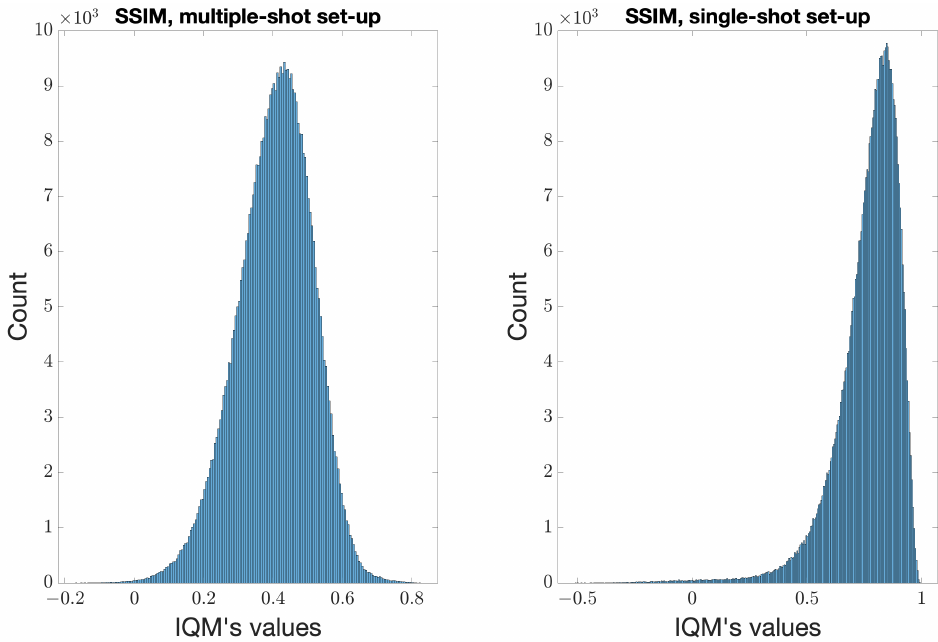
Figure 6. SSIM’s (mean) quality map histograms for the scissor image with 1 mm maximum height print used as test image and 0.25 mm maximum height print used as reference image from the MS ( left ) and the SS ( right ) captures. In the MS captures, the prints are noisier than in the SS ones.